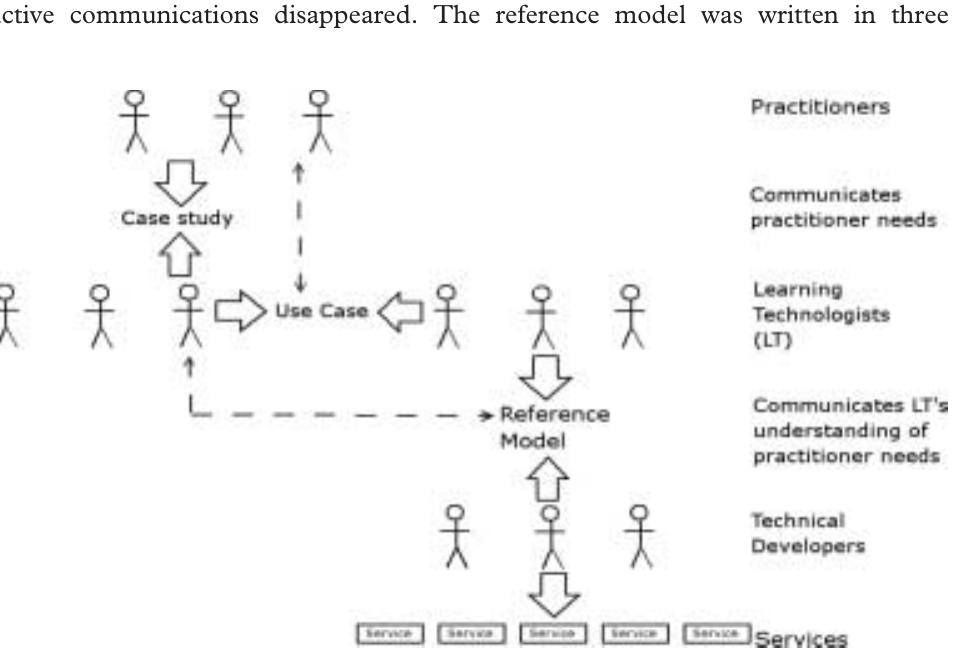
Figure 5. Communication structure and mediating representations used in the LADiE